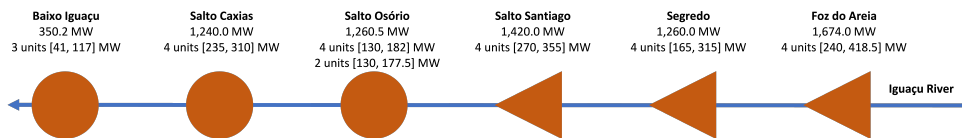
Figure 2. Part of the Brazilian Iguaçu basin. The plants given in triangular form have reservoirs capable of regularization, whereas those in circles are run-of-river plants. The total installed capacity in MW is shown for each plant, along with the number of units and their respective ranges of generation. For instance, Salto Santiago has four turbines, each of them with a minimum generation of 270 MW and maximum of 355 MW.